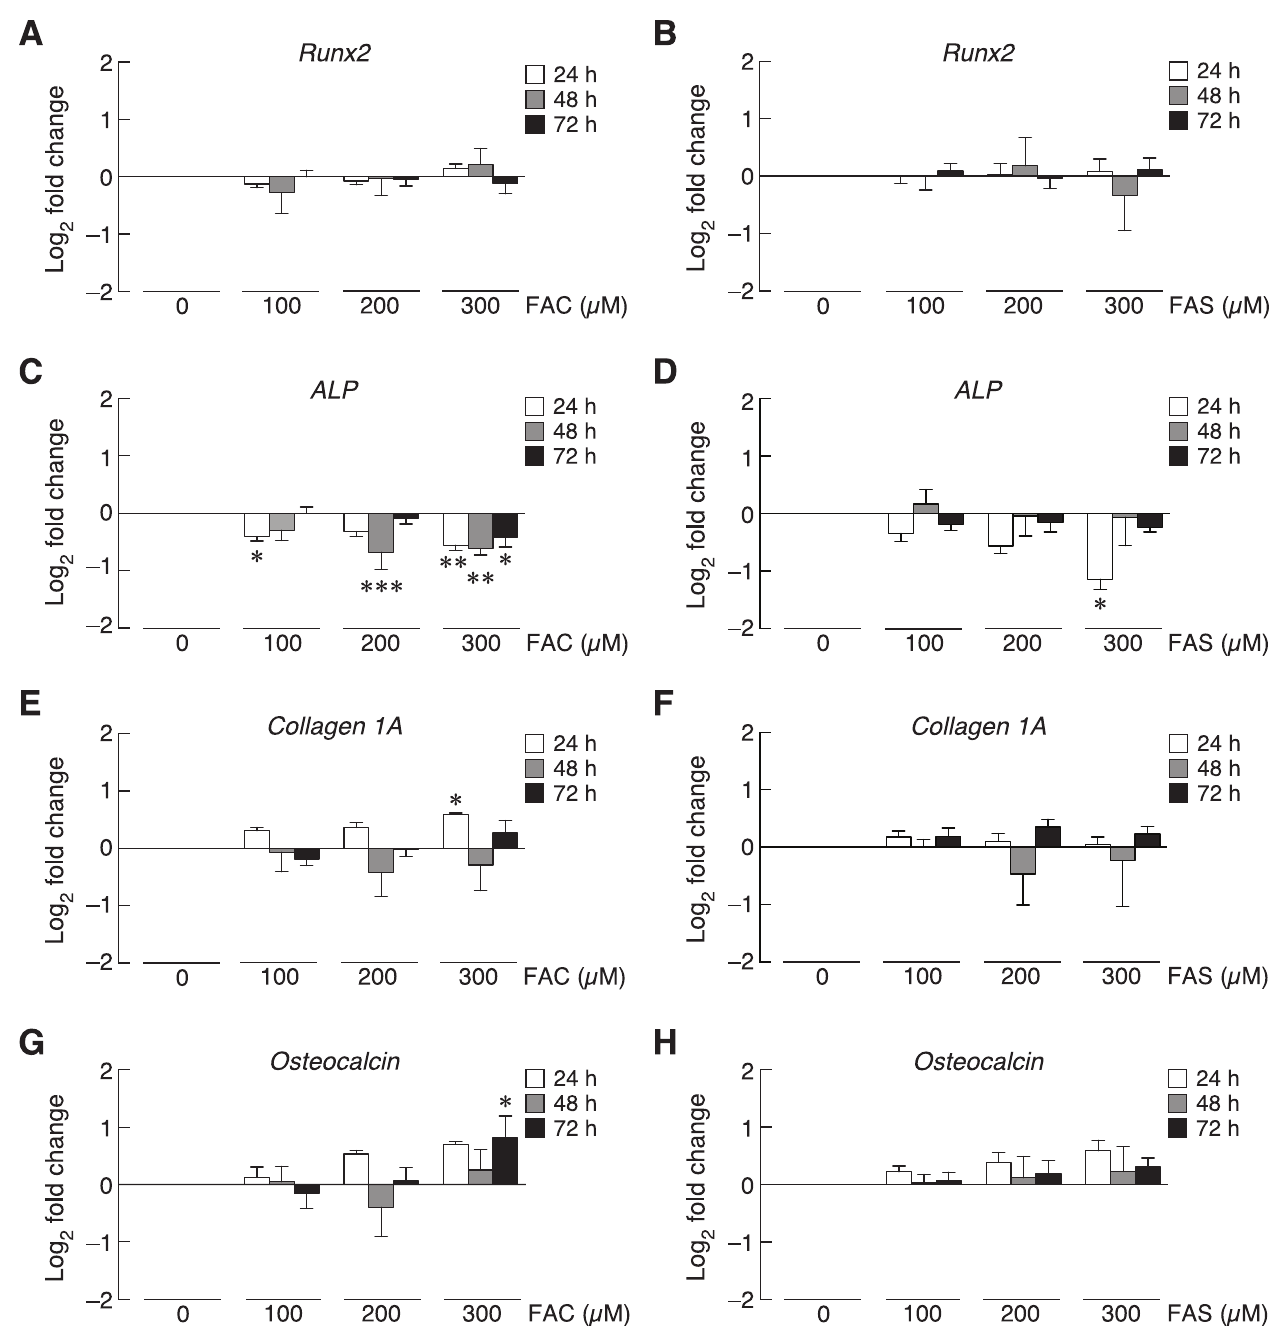
Fig 1. The expression of osteoblast differentiation markers in UMR-106 cells upon FAC and FAS exposure at 24, 48 and 72 h was determined by qRT-PCR. (A–B) Runx2, (C–D) alkaline phosphatase (ALP), (E–F) collagen I alpha (1A), and (G–H) osteocalcin expression upon FAC and FAS exposure. � P < 0.05, �� P < 0.01, ��� P < 0.001 as compared to control group (0 μ M).